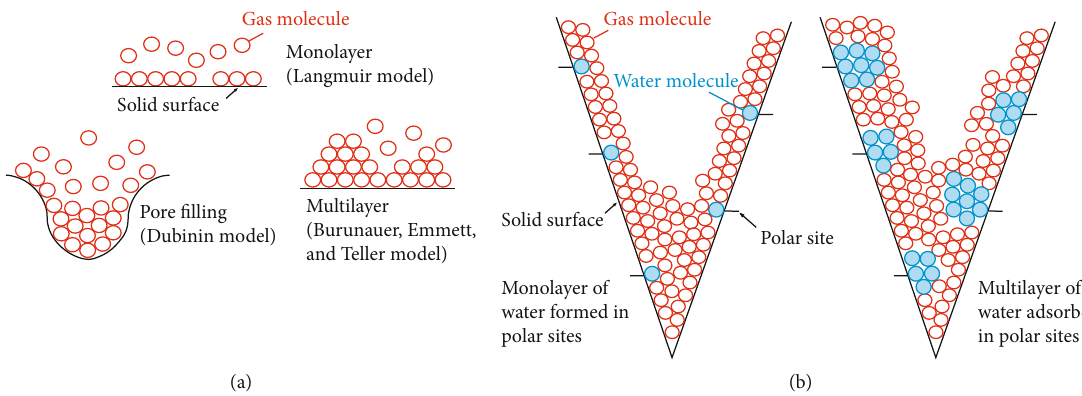
Figure 9: Simpli fi ed diagrams of a gas adsorption model (a) and a water molecule adsorption model (b) (modi fi ed from Day et al.